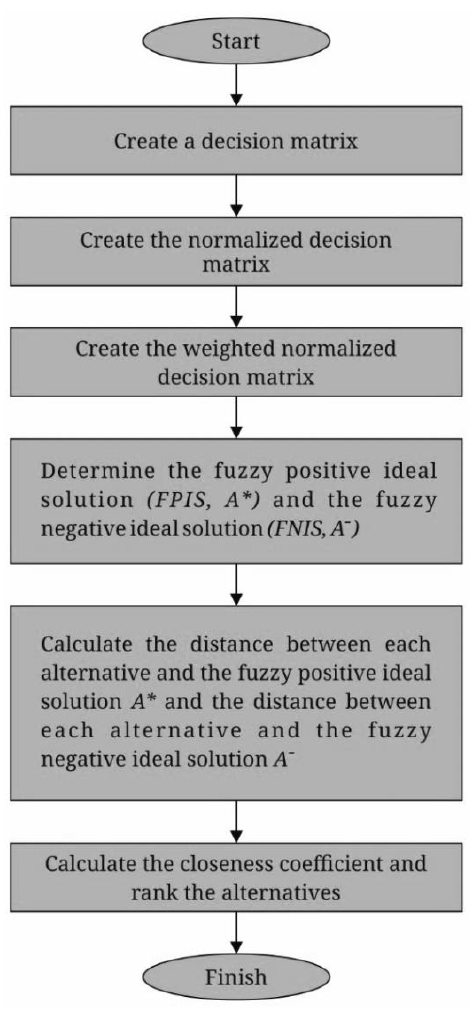
Figure 4. Steps of the fuzzy TOPSIS method.